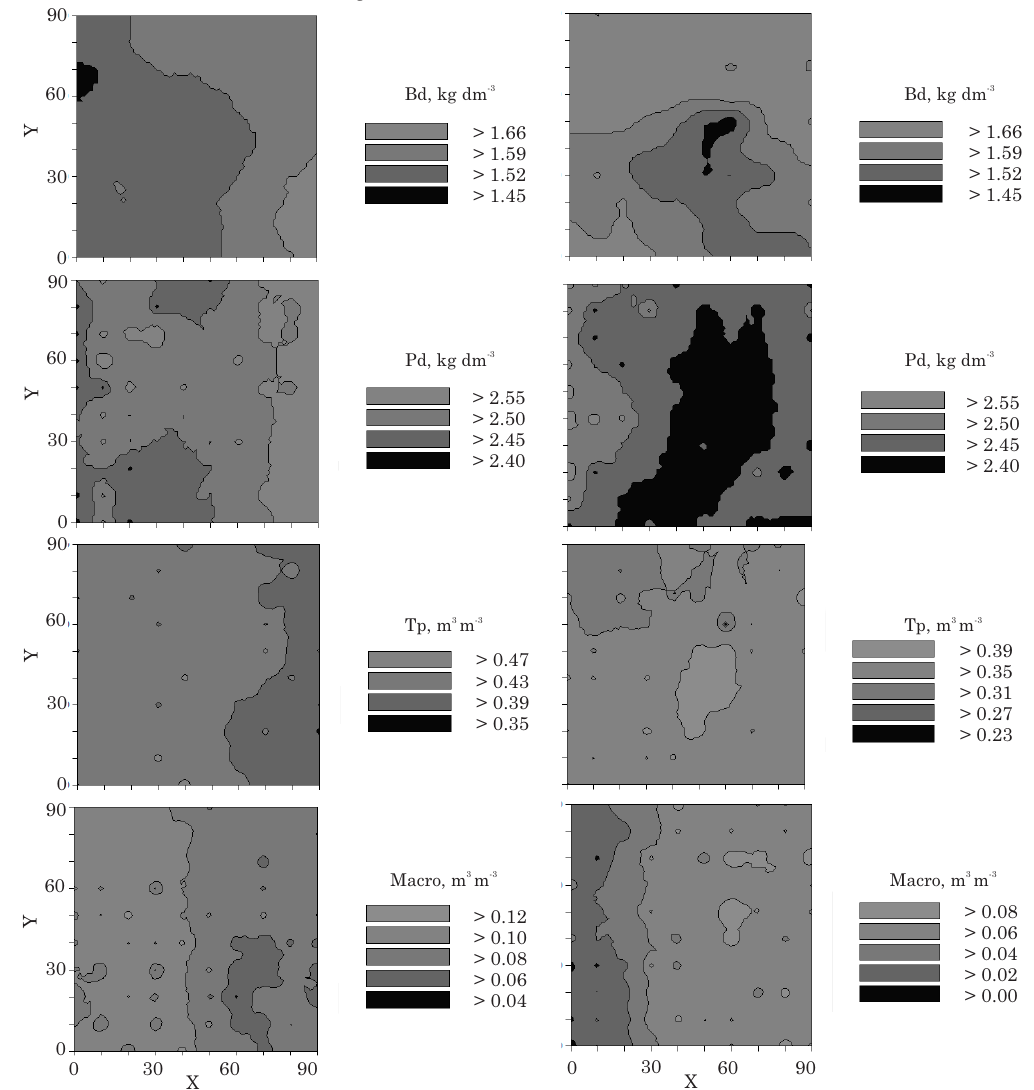
Figure 3. Maps of the spatial distribution of soil bulk density (Bd), particle density (Pd), total porosity (Tp) and macroporosity (macro) before and after land